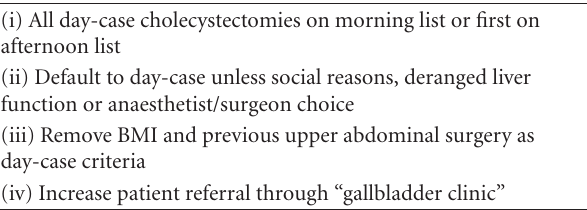
Table 2: Changes made to gallbladder pathway following interim audit in